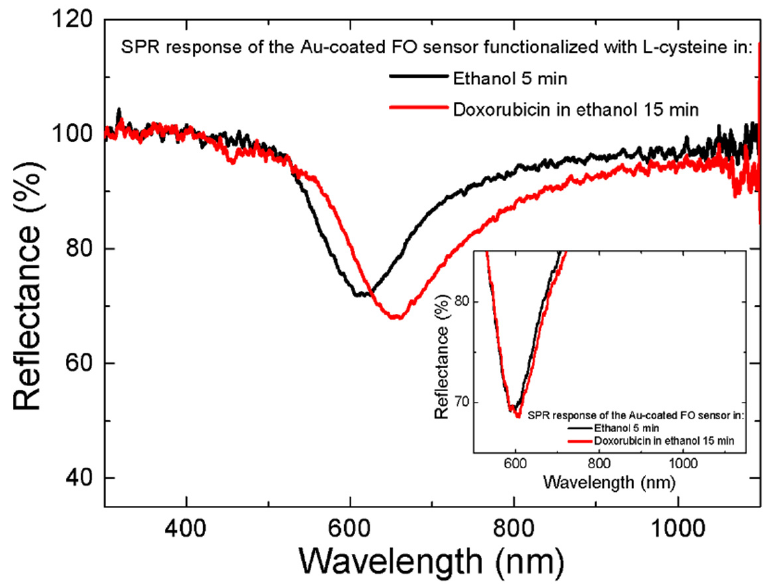
12 of 25 Figure 6. The real-time monitoring of Dox-L-Cys interaction using the FO-SPR system. The SPR spectral dips obtained in ethanol with the sensor functionalized with L-Cys, before (black curve) and after (red curve) Dox binding, respectively. The inset represents a specificity binding test, showing that in the absence of L-Cys on the FO-SPR sensor surface, only a SPR wavelength shift of 4 ± 0.4 nm was recorded for the 0.1 mM Dox solution. The binding mechanism between L-Cys and Dox can be generally explained by the reaction scheme depicted in Figure 7. The crosslinker agent EDC (1-ethyl-3-(3-dimethylaminopropyl)carbodiimide) 0.4 M was used to activate and to couple the carboxyl groups to doxorubicin amine via amide bonding.